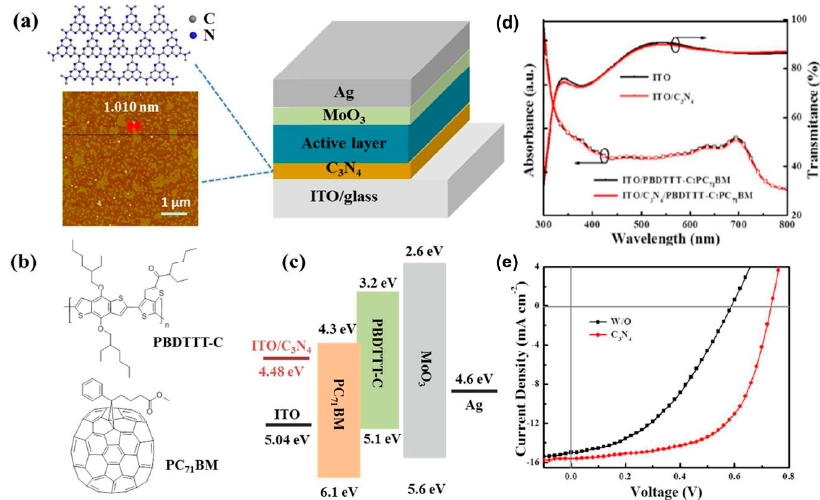
Figure 10. ( a ) Device configuration of the inverted PSCs using C 3 N 4 as cathode interfacial layers. The left images show the schematic structure of C 3 N 4 and the AFM topography image of C 3 N 4 nanosheets on mica substrates. ( b ) Chemical structures of donor material PBDTTT-C and acceptor PC71BM. ( c ) Schematic energy level diagram of the inverted PSCs. ( d ) Transmittance spectra of ITO and ITO/ C 3 N 4 and optical absorption spectra of ITO/PBDTTT-C: PC 71 BM and ITO/ C 3 N 4 /PBDTTT-C: PC 71 BM.